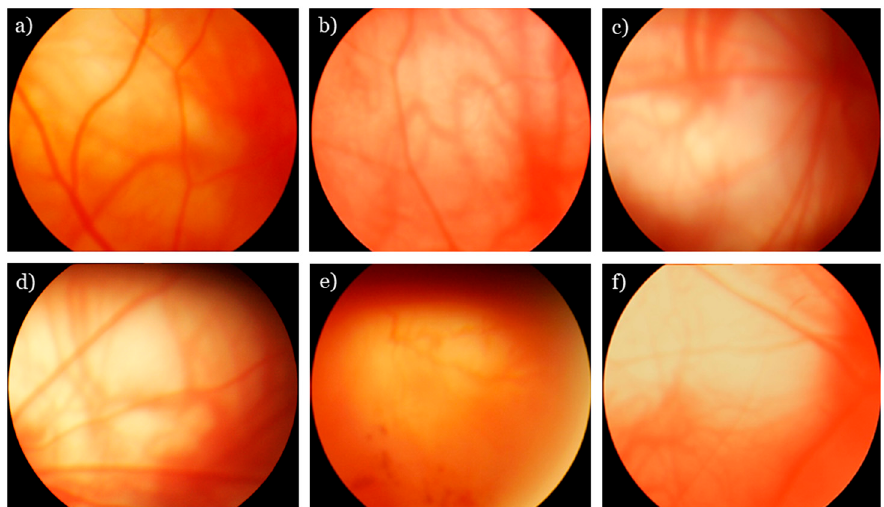
Figure 1. Fundus photographs of rat retinas. ( a ) A normal fundus from Wistar rat. The proportion of blood vessels is normal. The retina between vascular arcades is not damaged (or changed). ( b–f ) The fundus images from OXYS retinas: ( b ) A combination of multiple small drusen and a few medium- size drusen; this condition corresponds to 1 AU; ( c ) numerous intermediate reticular drusen without pigmentary irregularities; this condition corresponds to 2 AU; ( d ) obliteration of choroidal vessels, destruction and sclerosis of retinal vessels, and a sharply demarcated (usually round or oval) area of atrophy of the retinal pigment epithelium (RPE); this condition corresponds to 2 AU; ( e ) intraretinal hemorrhages with edema and serous detachment of the neurosensory retina and RPE, with neovascularization; this condition corresponds to 2 AU; ( f ) geographic atrophy of the RPE (3 AU).